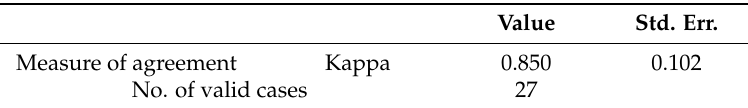
Table 4. Results of agreement analysis.